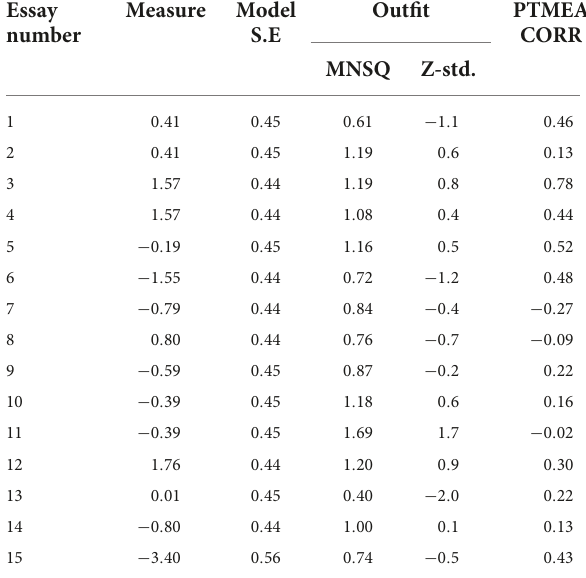
TABLE 3 Analysis of fit statistic for essay.